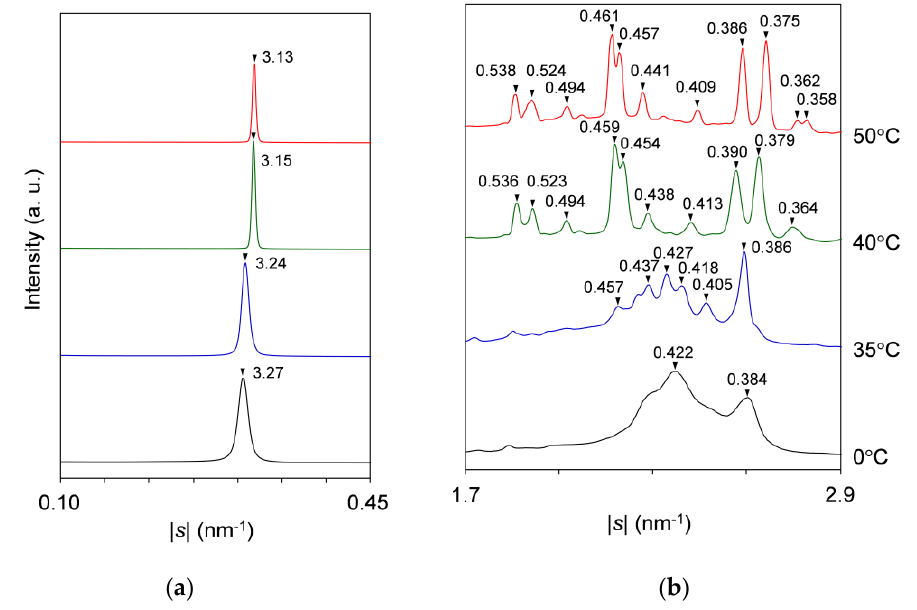
Figure 3. Representative SR-XRD profiles of SOS/LLL ( w LLL = 0.950) in the heating process of Figure 2: ( a ) SAXS; and ( b ) WAXS. Unit: nm.